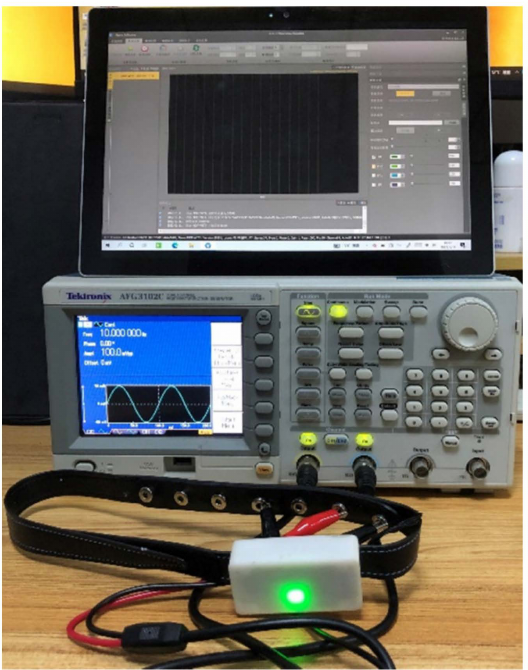
Figure 2. The connection between the arbitrary function generator and Mindeep in the simulated signal test